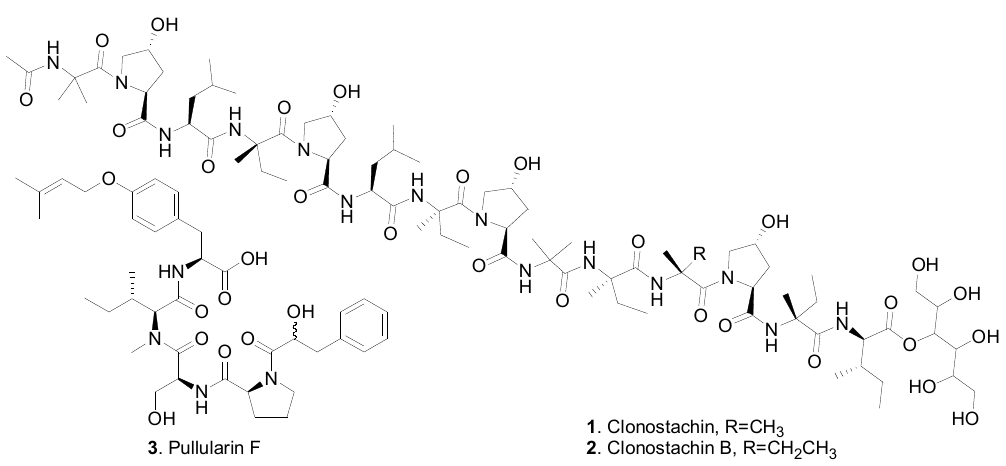
Figure 1. Linear oligopeptides isolated from Clonostachys fungi.